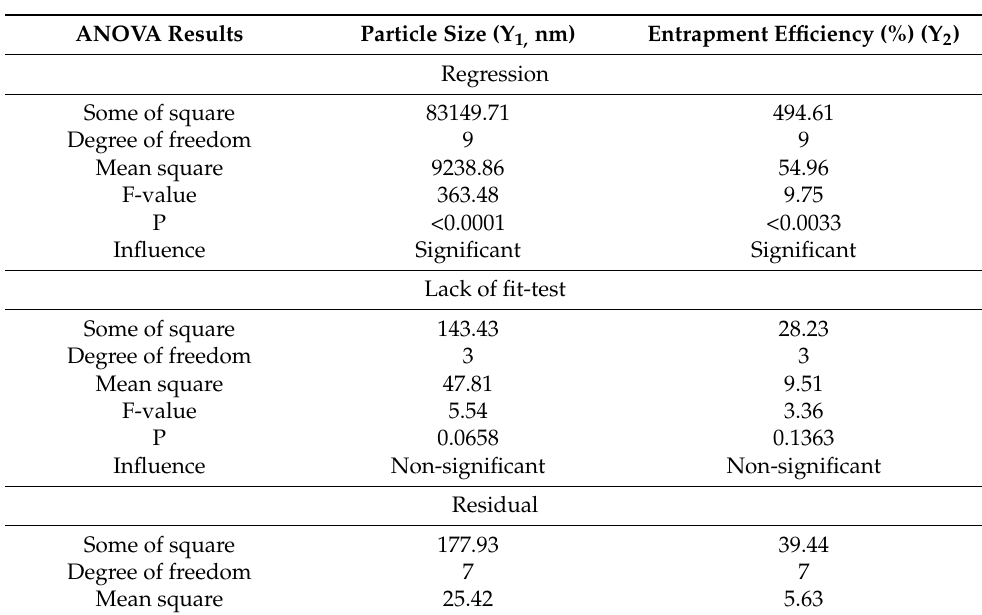
Table 4. ANOVA of quadratic model for responses of developed